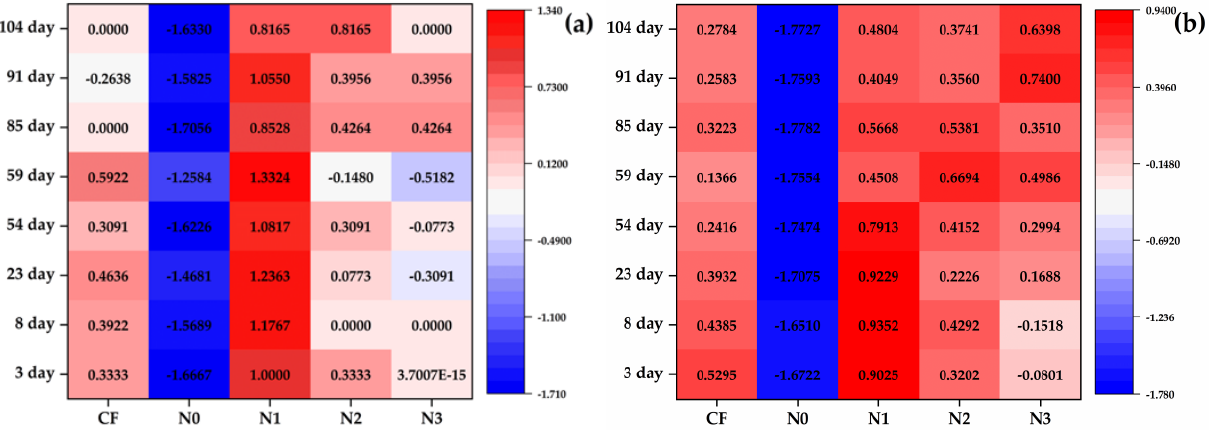
Figure 2. Heat map analysis of soil nitrate reductase activity in different treatments.